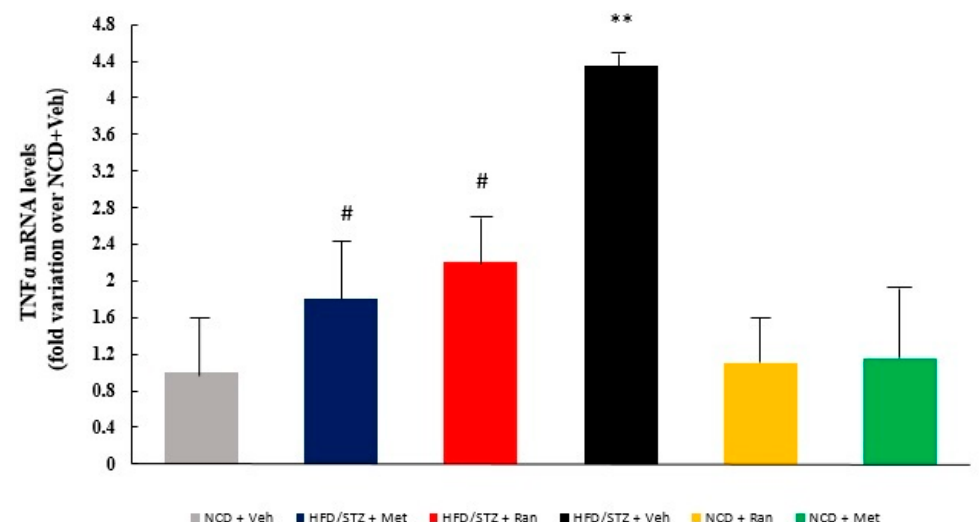
Figure 4. TNF α in each experimental group. Data values are the mean ± SE (standard error) after normalization for 18S levels, and expressed as fold variation over NCD + Vehicle group. ( n = 3–4 per group.) HFD = high fat diet; NCD = normocaloric diet; STZ = streptozotocin; Ran = ranolazine; Met = metformin; GFAP= glial fibrillary acidic protein. ** p = 0.01 HFD/STZ + Vehicle vs. NCD + Vehicle, # p = 0.01 HFD/STZ + Metformin and HFD/STZ + Ranolazine vs. HFD/STZ + Vehicle.